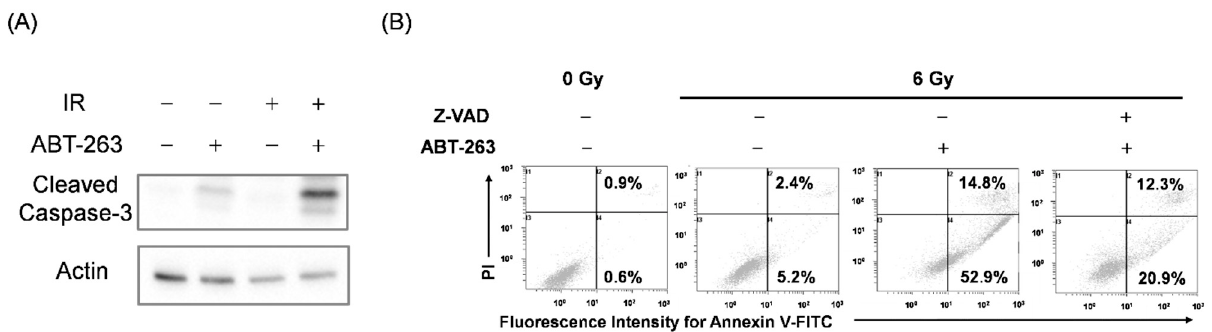
Figure 5. ABT-263 induces caspase-mediated apoptosis of irradiated A549 cells. ( A ) A549 cells irradiated at 6 Gy were cultured for 24 h prior to the addition of ABT-263 (5 μ M) to the culture. After 24 h of culture, the cells were harvested for western blot analysis. β -actin was used as a loading control. Representative immunoblots are shown. ( B ) A549 cells irradiated at 6 Gy were cultured for 24 h prior to the addition of ABT-263 to the culture. Z-VAD was added to the culture 1 h before ABT-263 administration. After 48 h of culture, the cells including floating cells were harvested for apoptosis analysis. Representative cytograms are shown. The inset numbers of the cytograms indicate the percentage of annexin V + /PI − cells or annexin V + /PI + cells.